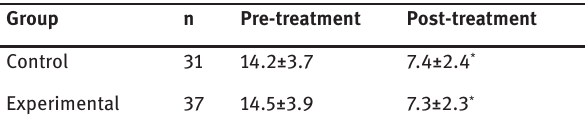
Table 3: Comparison of NIHSS scores between the two groups after 4 weeks of